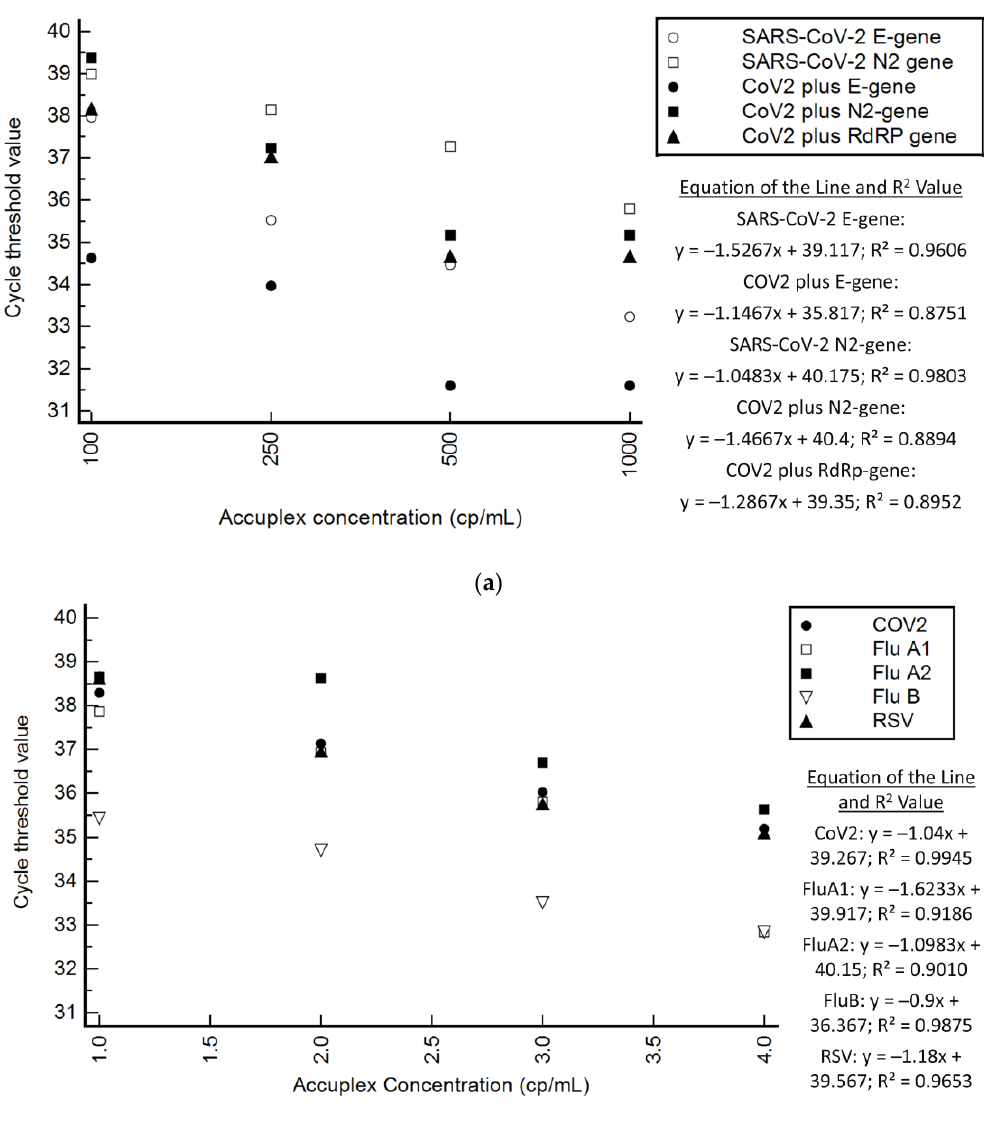
Mean Ct values, standard deviation (SD) and percentage coefficient of variation (%CV) per gene target and dilution are shown for the Xpert ® Xpress SARS-CoV-2 and Xpert ® Xpress CoV-2 plus tests. Overall mean Ct, SD and %CV are also provided. Gene targets refer to the SARS-CoV-2 envelope (E), nucleocapsid 2 (N2), open reading frame 1ab (ORF1ab) and RNA-dependant RNA polymerase (RdRp) genes. Ct: cycle threshold; cp/mL: copies per millilitre.